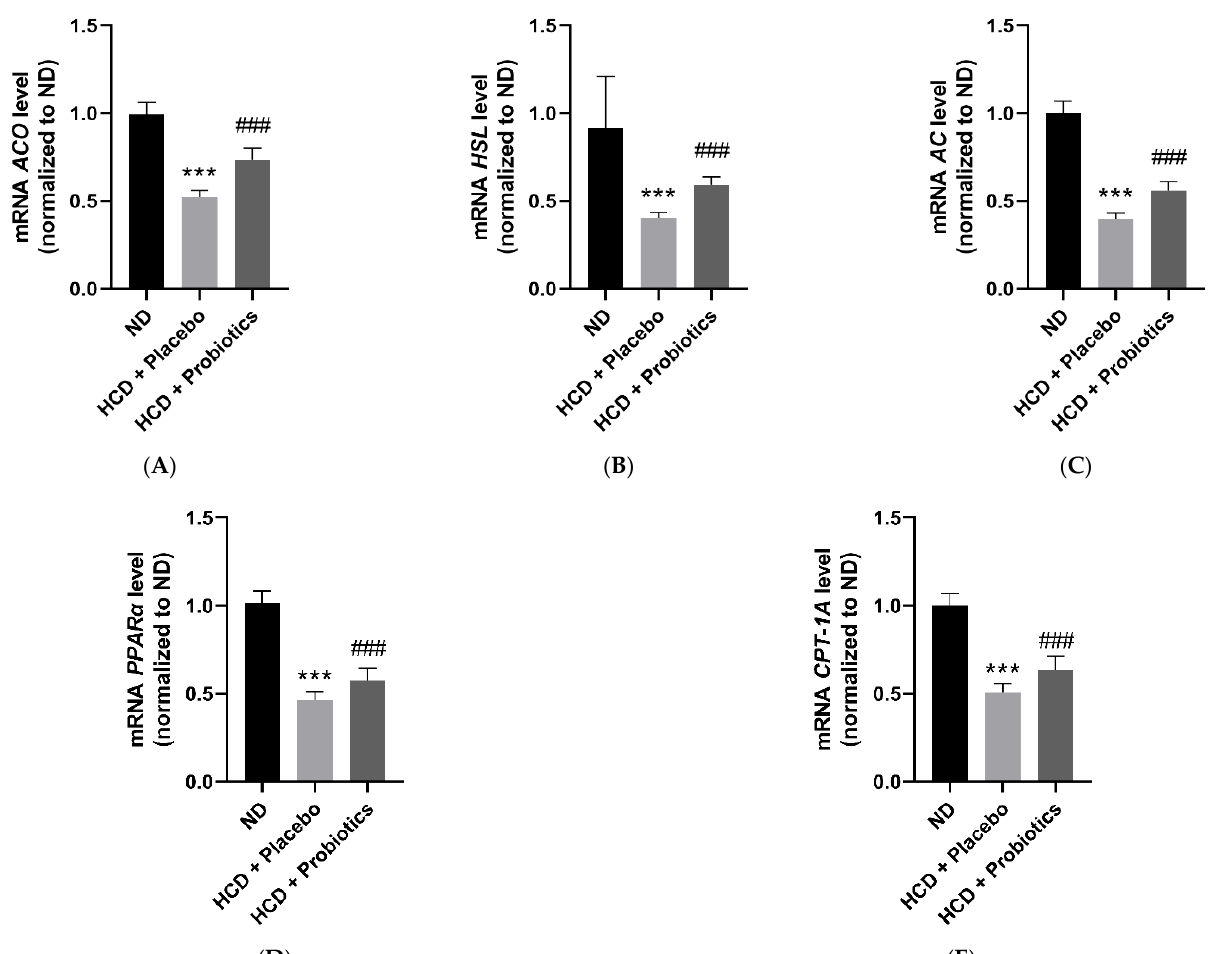
Figure 4. Effect of MSPs on adipolysis and fatty acid oxidation in the visceral adipose tissues of HCD-fed mice. ( A – C ) mRNA expression of lipolysis-promoting genes in visceral adipose tissues. ( D , E ) mRNA expression of fatty acid oxidation-promoting genes in visceral adipose tissues. Data are expressed as mean ± standard deviation ( n = 5 per group). *** p < 0.001 vs. ND; ### p < 0.001 vs. HCD + placebo. Legend: AC , adenylyl cyclase; ACO , acyl CoA oxidase; CPT-1A , carnitine palmitoyltransferase-1A; HCD, high-carbohydrate diet; HSL , hormone-sensitive lipase; mRNA, messenger ribonucleic acid; MSPs, multi-strain probiotics; ND, normal diet; PPAR- α , peroxisome proliferator-activated receptor